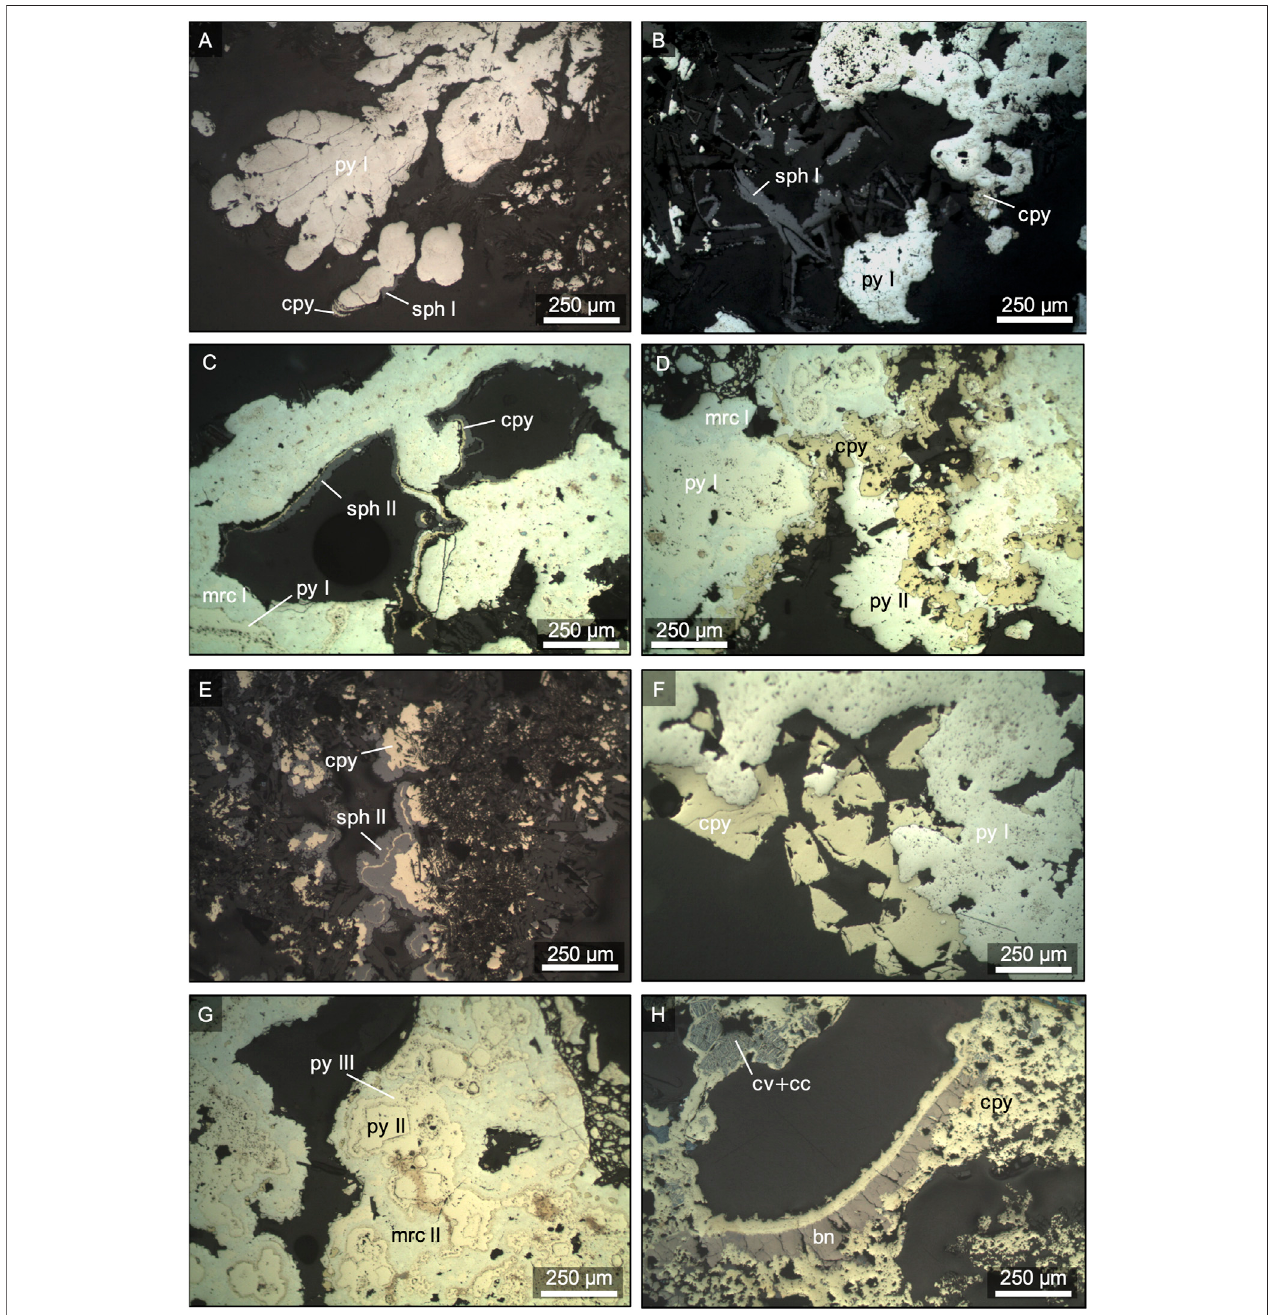
FIGURE 2 | Photomicrographs in re fl ected light of representative sulphide-sulphate samples from Maka volcano. (A) Colloform pyrite I (py I) surrounded by sphalerite I (sph I) and chalcopyrite (cpy, 122 ROV-24, Maka South). (B) Sulphide assemblage in the outer chimney wall consisting of pyrite I, sphalerite I and minor chalcopyrite (116 ROV-17R, Maka HF). (C) Early pyrite I surrounded by marcasite I (mrc I) and followed by chalcopyrite and late-stage sphalerite II (sph II, 116 ROV-17, Maka HF). (D) Pyrite I and marcasite I assemblage surrounded by chalcopyrite and pyrite II of the high temperature stage (116 ROV-17, Maka HF). (E) Alternations ofchalcopyriteandsphaleriteII(122ROV-24,MakaSouth). (F) PyriteIsurroundedbysubhedralchalcopyrite(122ROV-22,MakaSouth). (G) Hightemperatureeuhedral pyrite II associated with late-stage pyrite III (py III) and marcasite II (mrc II, 116 ROV-17, Maka HF). (H) Chalcopyrite lining around fl uid conduit replaced by supergene bornite (bn), covellite (cv) and chalcocite (cc, 122ROV-18, Maka South). Estimations of mineral abundances in the different samples are presented in Table 3 .